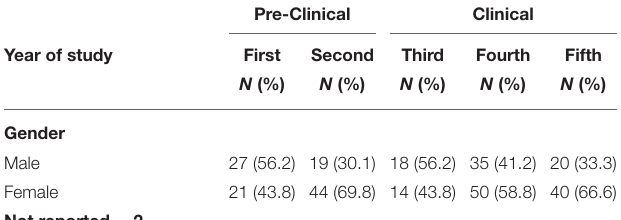
TABLE 1 | Participant and year of study group